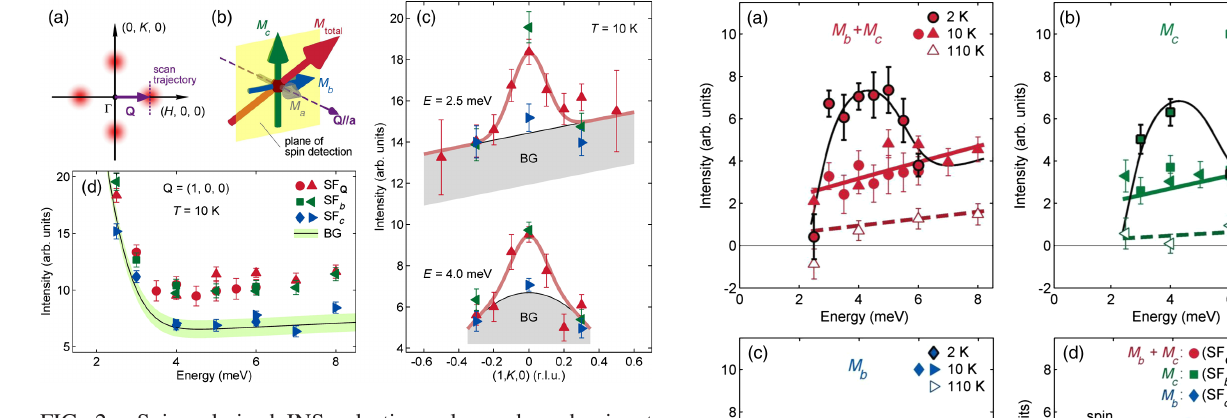
FIG. 2. Spin-polarized INS selection rules and predominant M contribution to the magnetic signal. (a) Distribution of c low-energy magnetic signals in momentum space. (b) Total spin fluctuations ( M ) and its three components, two of which can total be detected by INS at Q ¼ ð 1 ; 0 ; 0 Þ with selection rules described in the text. (c) Momentum scans at fixed energies ( E ) along a trajectory shown in (a). (d) Energy scans at fixed Q ¼ ð 1 ; 0 ; 0 Þ . Panels (c) and (d) share the same legends that indicate the three spin-flip channels. The two sets of symbols in (d) represent data obtained with different sample-environment devices. The BG intensity is determined from the selection rule: BG ¼ SF − SF SF Q , taking all available data points into account (see c Supplemental Material [21]). Shaded area in (d) indicates stat- istical uncertainty of our BG determination.